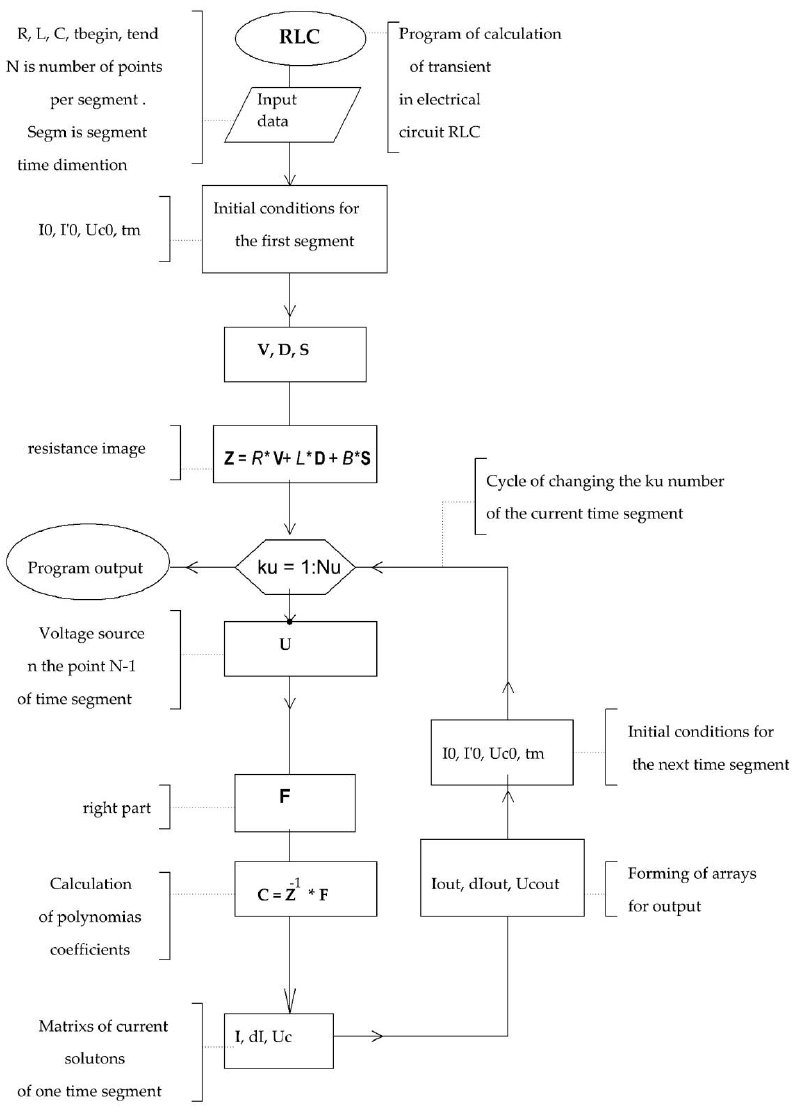
Figure 3. Block-diagram of calculation.